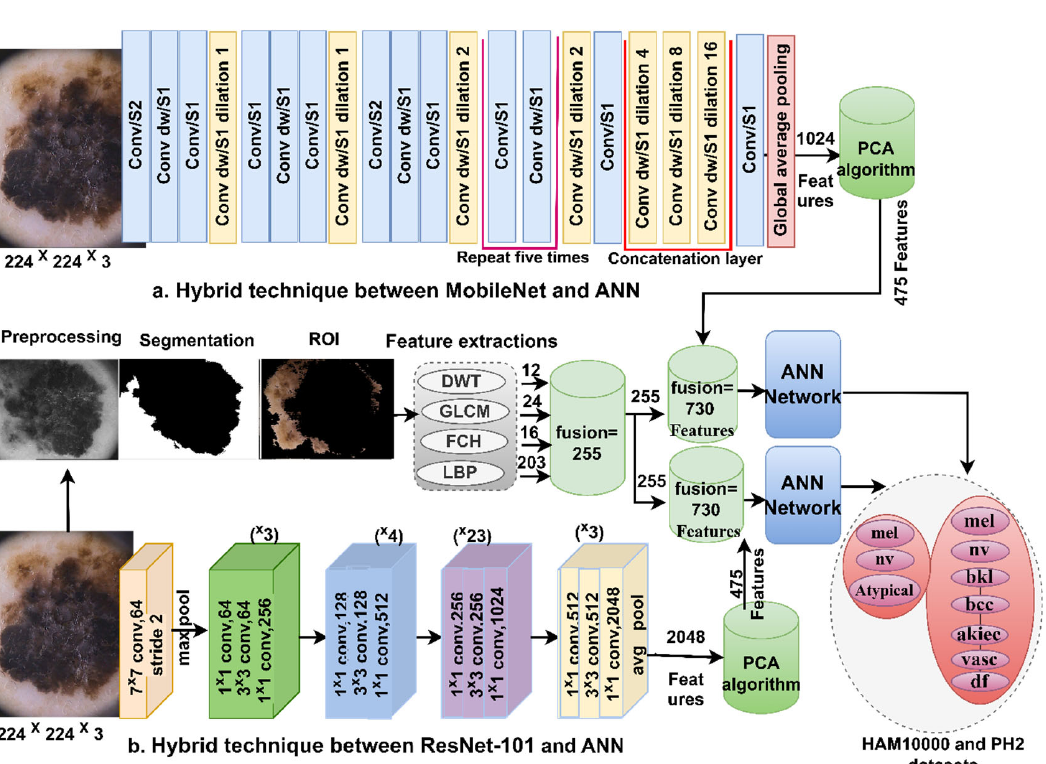
Figure 7. Methodology for classifying dermoscopic images from two datasets, HAM10000 and PH2, by ANN with hybrid features for CNN and handcrafted models.